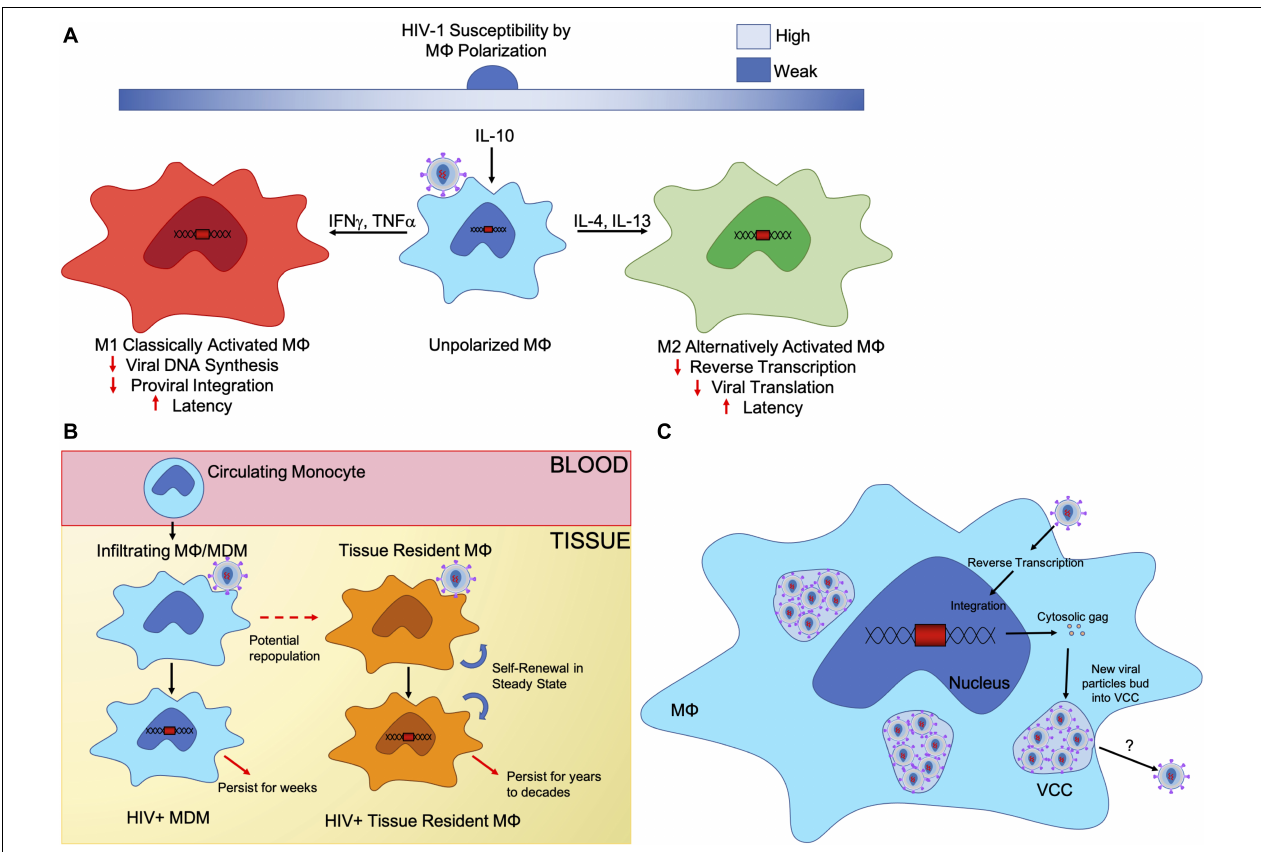
FIGURE 1 | Biological characteristics of macrophage reservoirs. (A) Unpolarized macrophages are stimulated by the local cytokine milieu in different tissue compartments, which causes different macrophage polarization states. Macrophage polarization is a spectrum and reversible. Two extremes are the M1, classically activated or pro-inflammatory, macrophage and the M2, alternatively activated or anti-inflammatory, macrophage, who play different roles within the body. Upon HIV-1 infection, polarization states affect susceptibility of macrophages as well as inhibit viral replication at different points in the HIV-1 replication cycle. (B) Tissue resident macrophages are sustained by self-renewal, and in some tissue, infiltrating macrophages will replenish tissue resident macrophage populations. Both monocyte derived macrophages and tissue resident macrophages are susceptible to HIV-1 infection and can sustain long-term infection with tissue resident macrophages maintaining viral infection for years to decades. (C) Virus containing compartments (VCCs) are formed from the introduction of gag synthesis in the cytosol, promoting the formation of compartments. Viral particles assemble then bud into these VCCs, accumulating over time. Upon cell necrosis or stimulation from the microenvironment, VCCs may release their viral